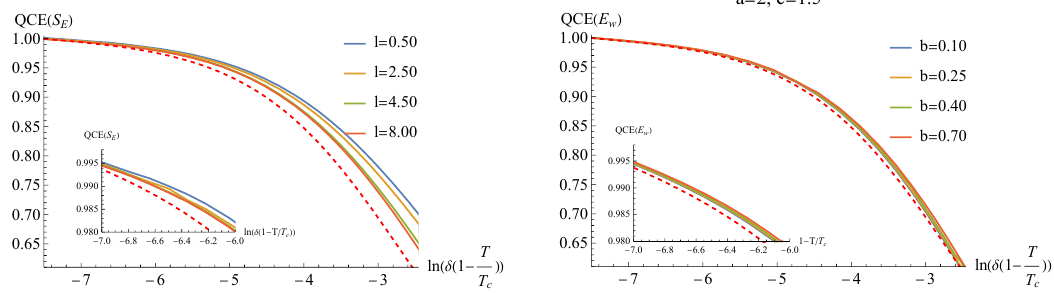
)) with different width of Tc )) with different values of c . T c